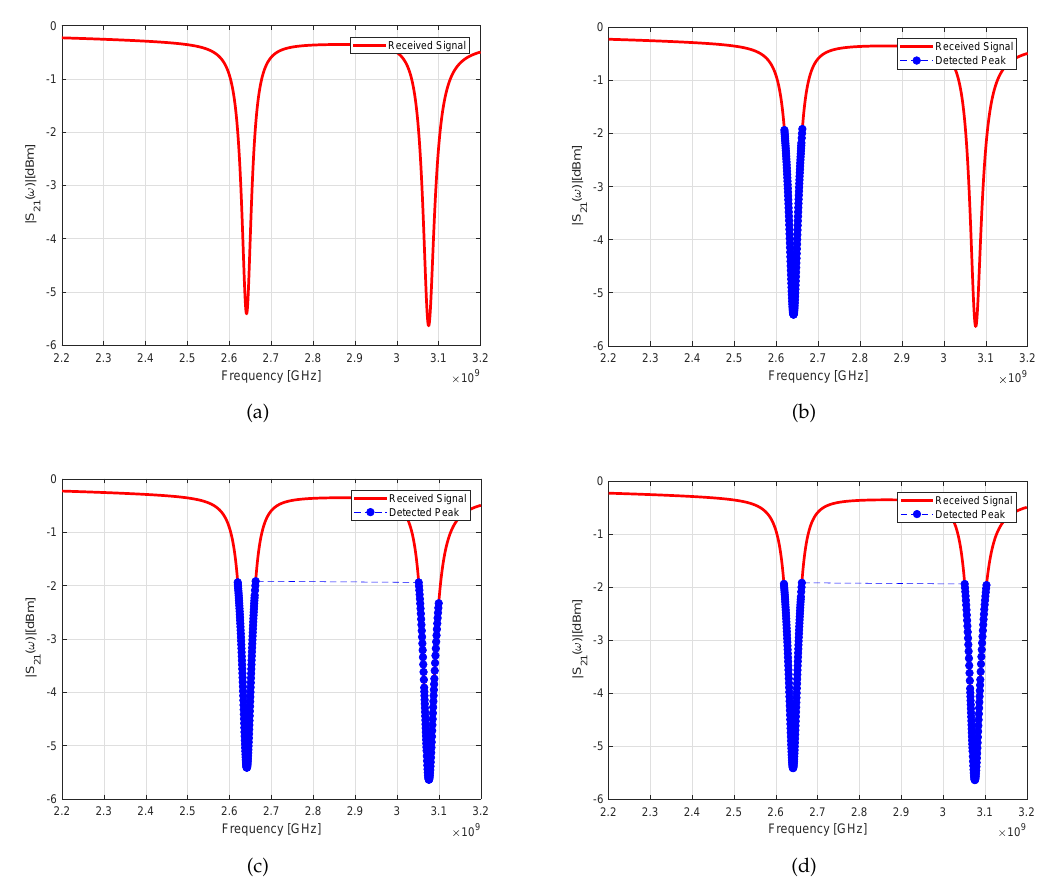
Figure 6. Peak detected for the tag configuration of 00101, ( a ) original detected signal, between the frequency range of ( b ) 2.6–2.7 GHz, ( c ) 3.0–3.1 GHz, and ( d ) 2.2–3.2 GHz with a frequency shift at 3.1–3.2 GHz.